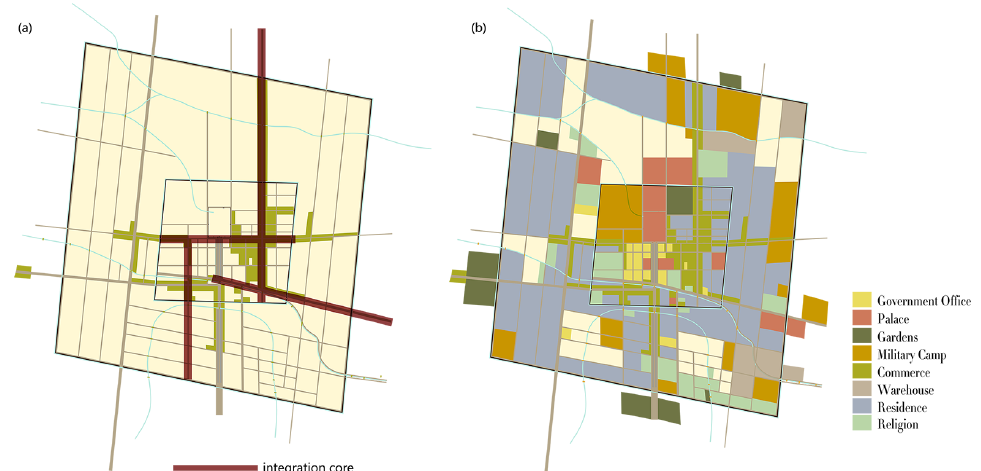
Figure 23. ( a ) The integration core of Dongjing city; ( b ) Functional distribution diagram of Dongjing City of the Song Dynasty based on Lu and the papers by Ye et al.